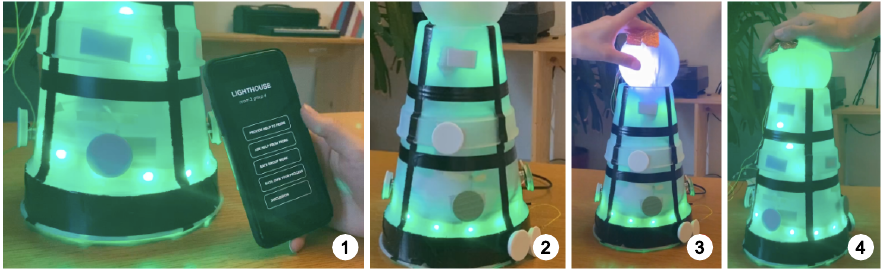
Figure 5. Tower technical prototype ( 1 . use app to communicate with other groups; 2 . place magnets on the Tower to choose an answer, green means I am confident , white means I am not sure ; 3 . rotate top bulb to seek help; 4 . touch top bulb to finish the activity).